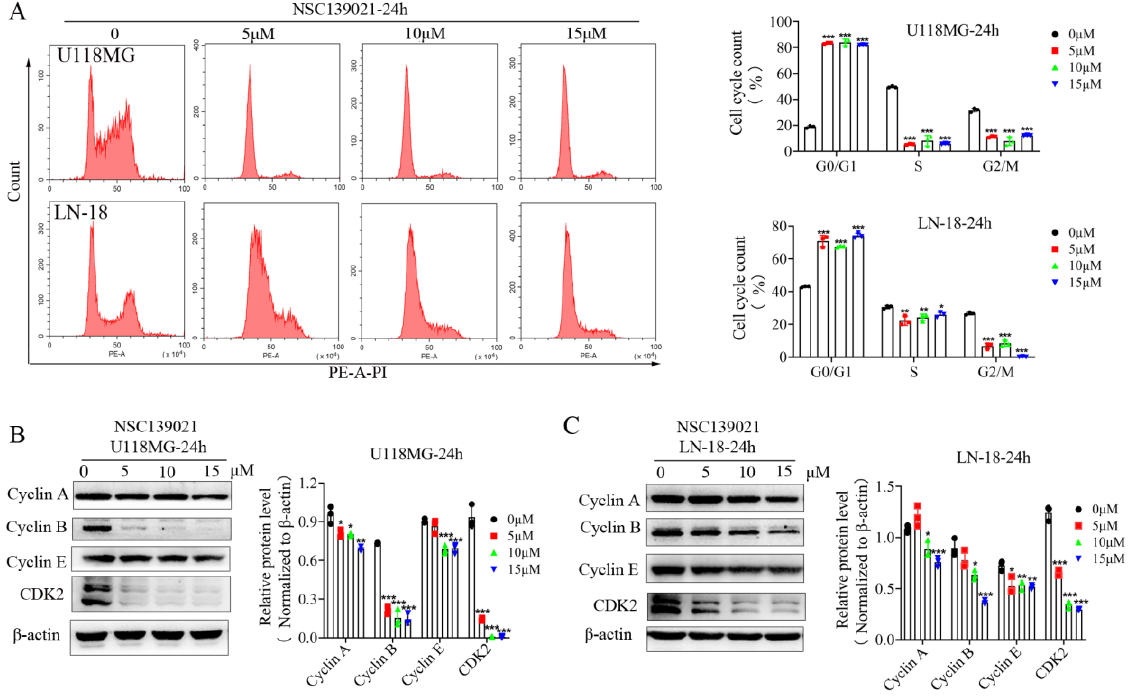
Figure 2. NSC139021-induced G0/G1-phase cell cycle arrest in glioblastoma cells. ( A ) Flow cytometric analysis with PI staining showed that the percentage of the G1 phase significantly increased, and the percentage of the S phase, as well as the G2/M phase, decreased after NSC139021 (5, 10, 15 µ M) treatment in U118MG and LN-18 cells. Quantification of cell populations was plotted on the right panel. ( B ) Western blot analysis showed that NSC139021 (5, 10, 15 µ M) treatment inhibited the expression levels of cell cycle-related proteins (Cyclin A, B, E, and CDK2) in U118MG cells. ( C ) Western blot analysis also showed that NSC139021 (5, 10, 15 µ M) treatment inhibited the expression levels of cell cycle-related proteins (Cyclin A, B, E, and CDK2) in LN-18 cells. β -actin was used as an internal control. The protein levels were quantified and normalized to β -actin and plotted on the right panel. The data were represented as the mean ± SD of three independent experiments. * p < 0.05, ** p < 0.01, *** p < 0.001 when compared to the DMSO